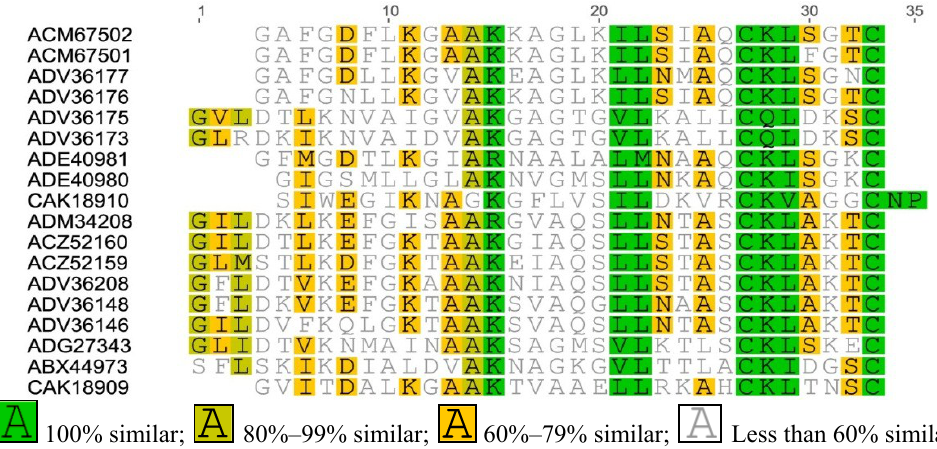
Figure A2. Multiple sequence alignment of Brevinin-2 from Asian